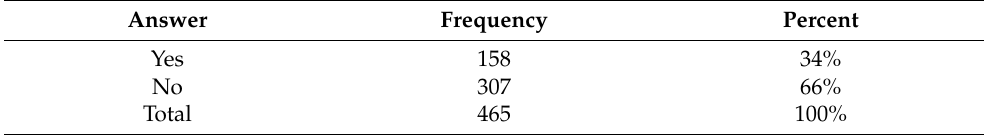
Table 3. Social engineering